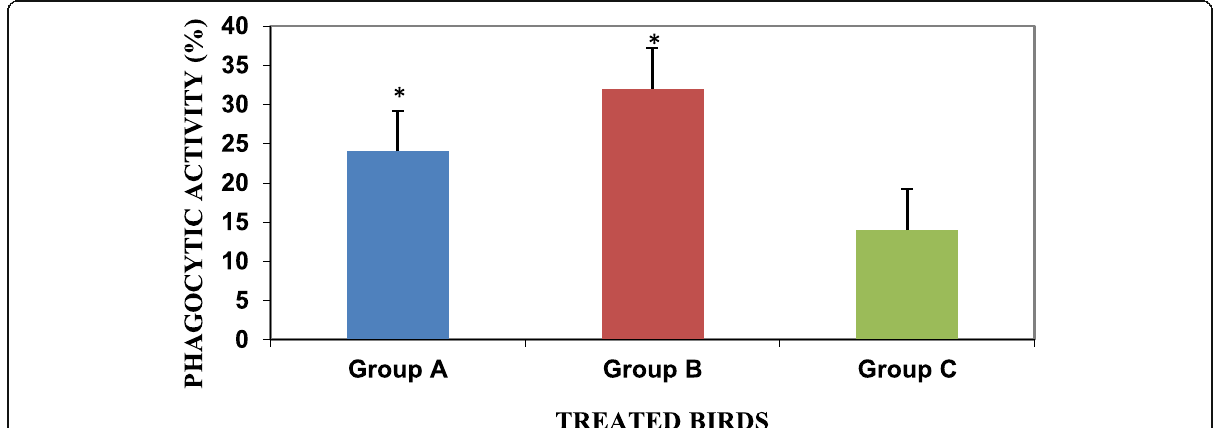
Fig. 6 Phagocytic activity of intestinal intra-epithelial leucocytes (iIEL) of control and MG-fed broiler birds after challenge with ND virus